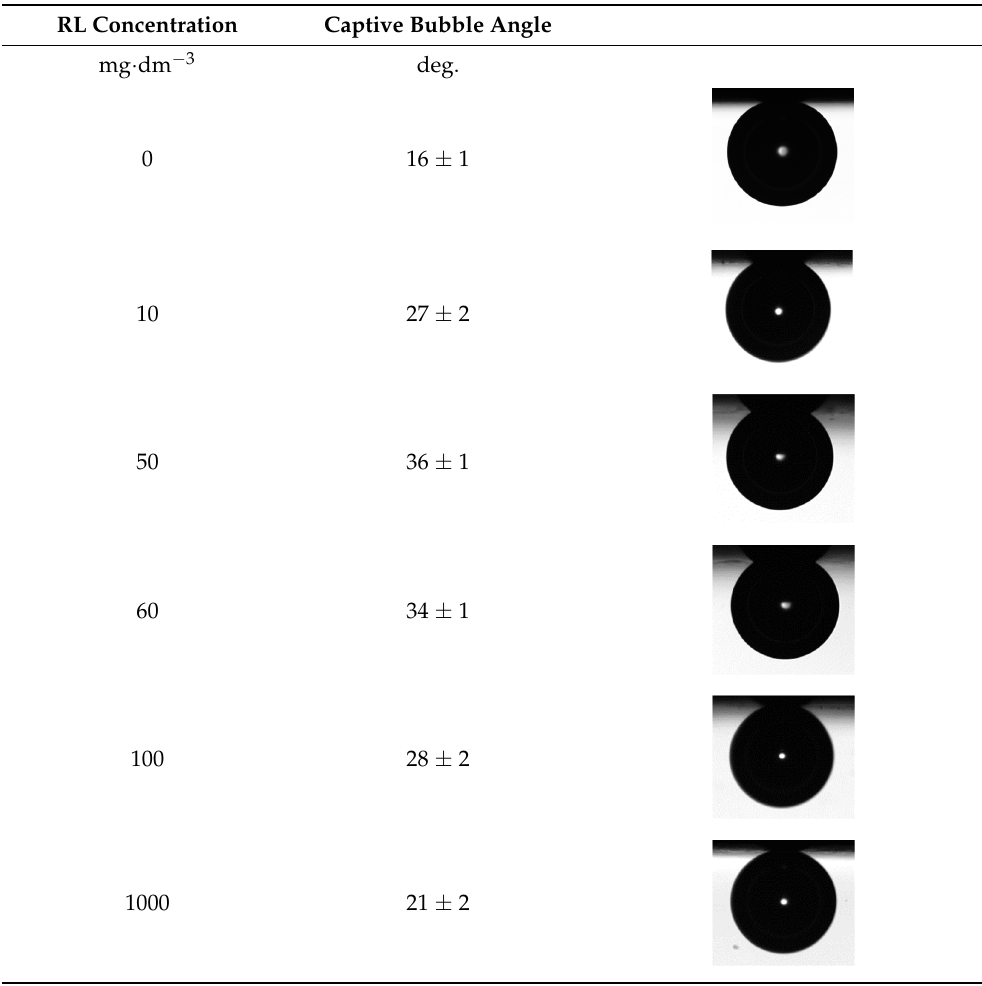
Table 2. The contact angle (measured through the aqueous phase) of the dolomite surface measured in RL solutions of different concentrations.